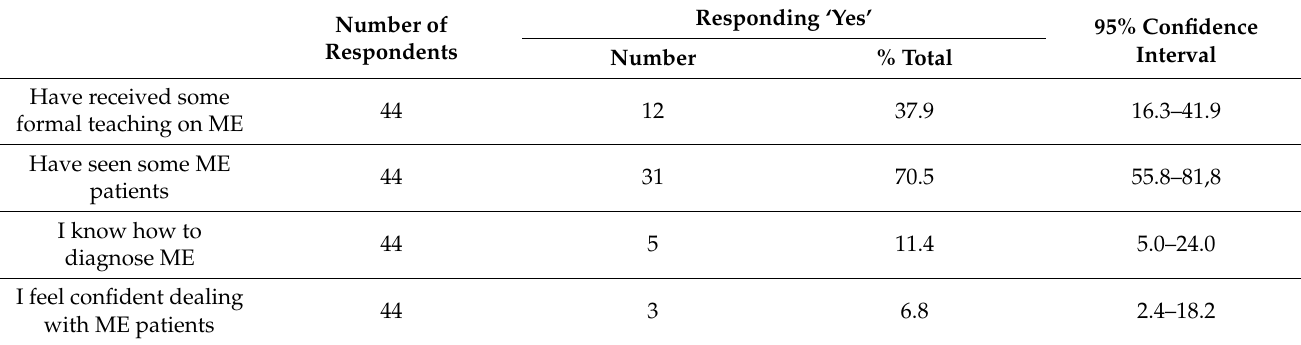
Table 1. Prior teaching and experience of ME, confidence to diagnose and manage it. Number